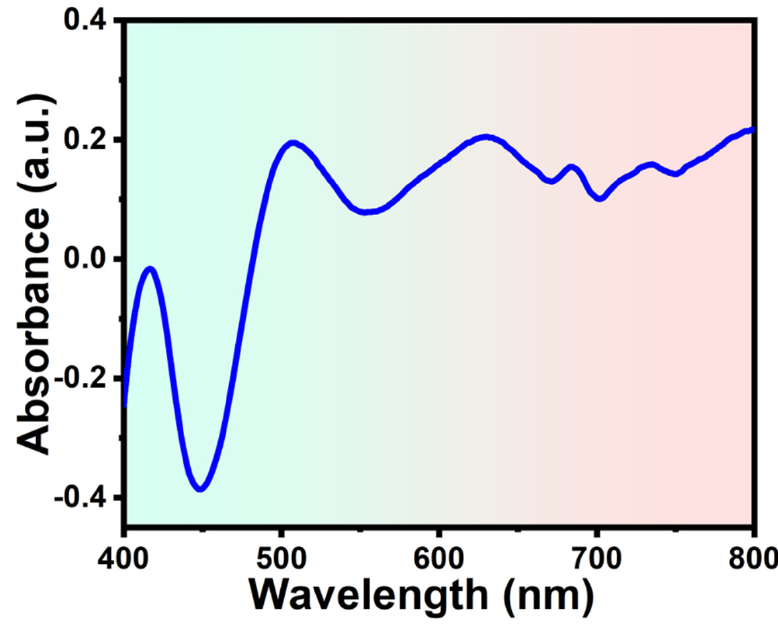
Figure 8. Absorbance analysis of HfO 2 ARC layer-based c-Si solar cell.